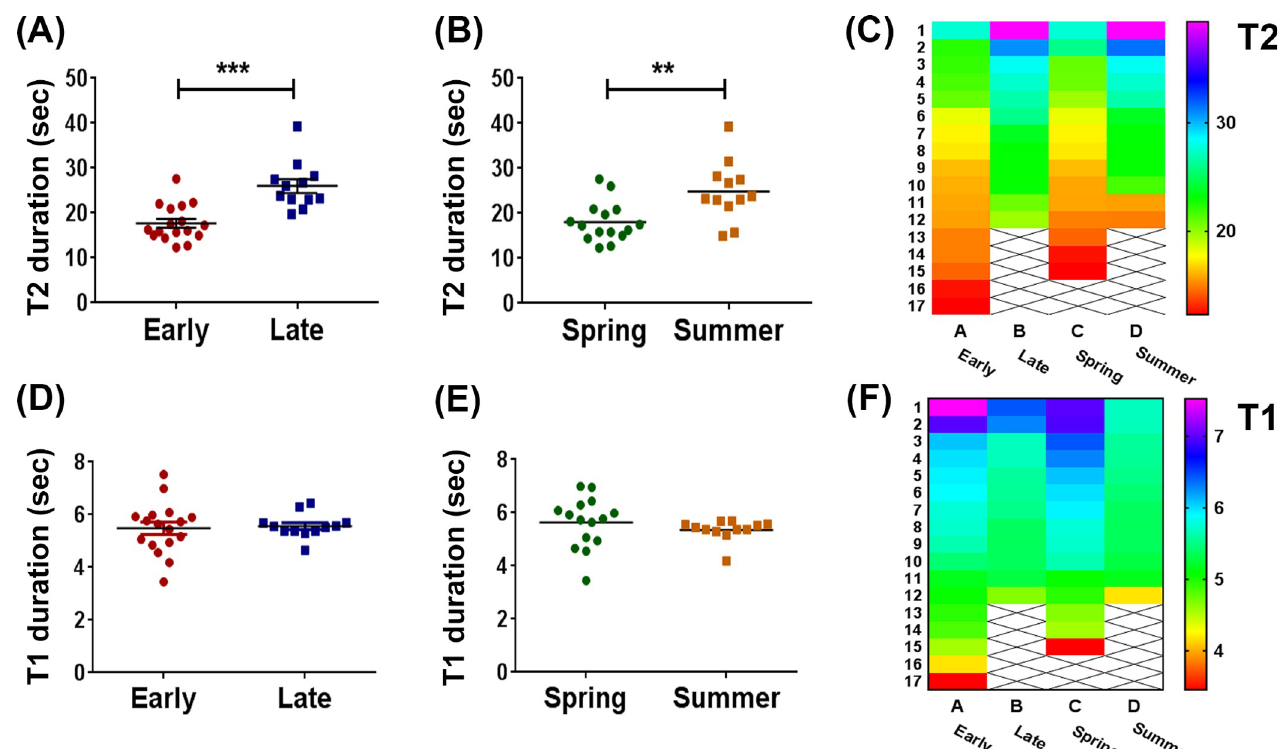
Fig 3. Daily and seasonal variation in timing between calls. (A) T2 duration in early vs. late owls (p < 0.0001), (B) T2 duration in spring vs. summer owls (p = 0.0037), (C) Heat map for T2, (D) T1 duration in early vs. late owls (p = 0.7574), (E) T1 duration in spring vs. summer owls (p = 0.3147), (F) Heat map for T1. Data from scatter dot plots represent the mean value for each owl. In heat maps, each row corresponds to the mean value per owl, and the columns represent the different groups (n = 17 for early owls, n = 12 for late owls, n = 15 for spring owls, and n = 12 for summer owls). ��� p < 0.0001, �� p < 0.01, two- tailed Student